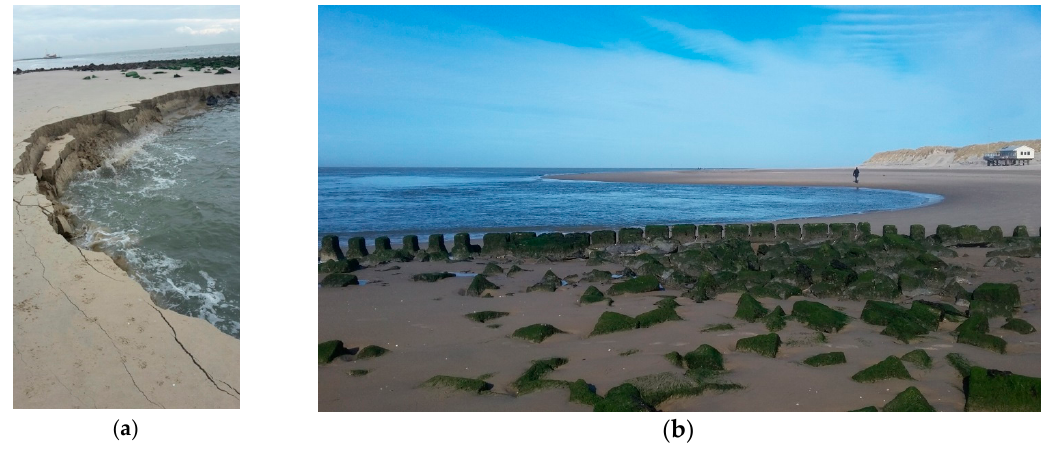
Figure 11. Beach collapse or RBF event at Ameland Island Southwest, Netherlands, near coastal protection groyne, 2017. Photo ( a ): J. Kanger-Wijnberg ( b ): Staatsbosbeheer.